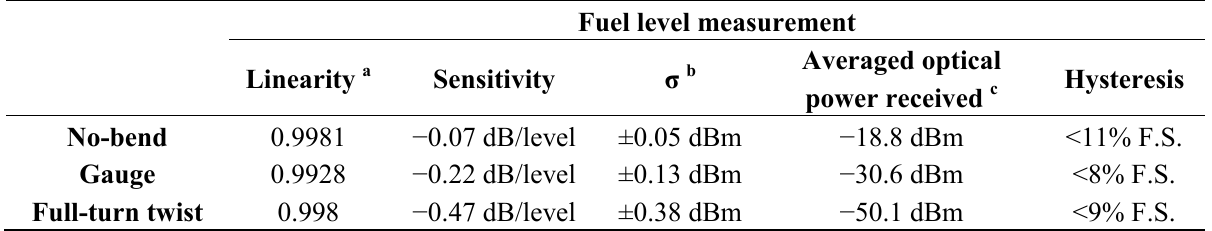
Table 2. Statistics of the experimental data in fuel level measurements at 650